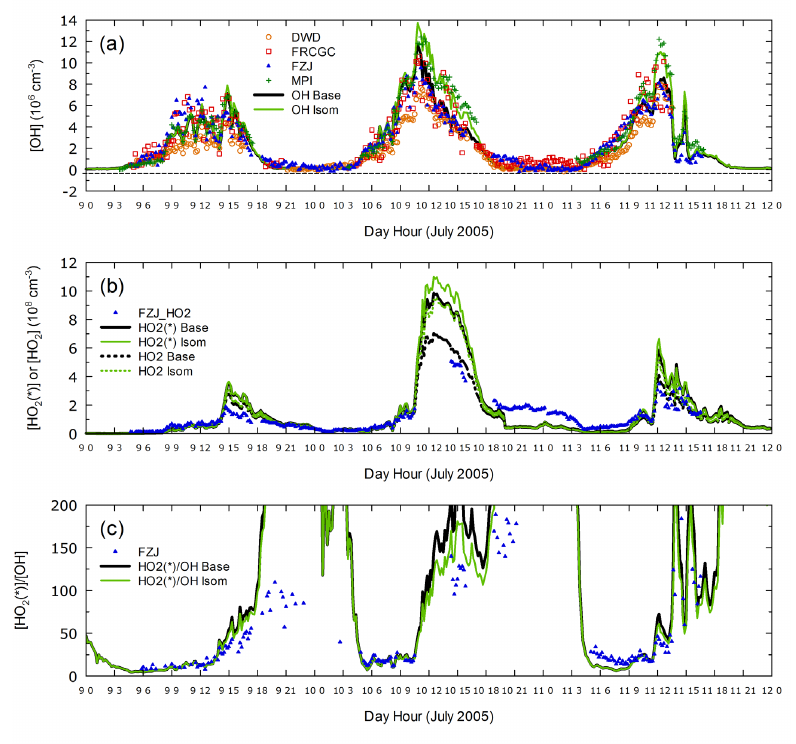
Fig. 1. Comparisons of observed and modeled (a) OH and (b) HO 2 (*) concentrations, and (c) HO 2 (*)/OH ratios. The results from the Base and Isom runs are shown.